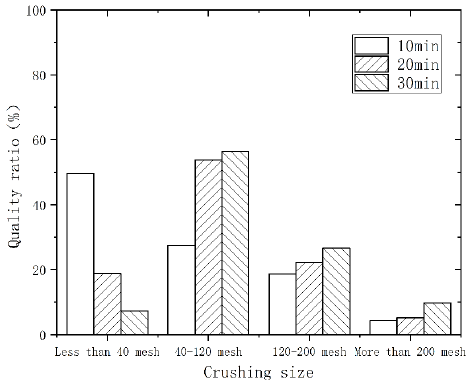
Figure 2. Particle size distribution for different times at 3000 r/min.